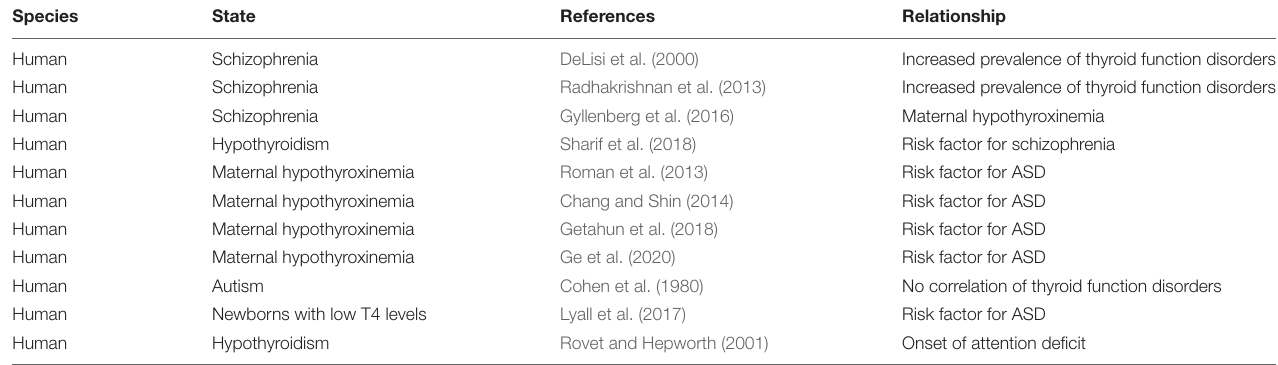
TABLE 3 | Relationship between thyroid diseases and psychiatric disorders.